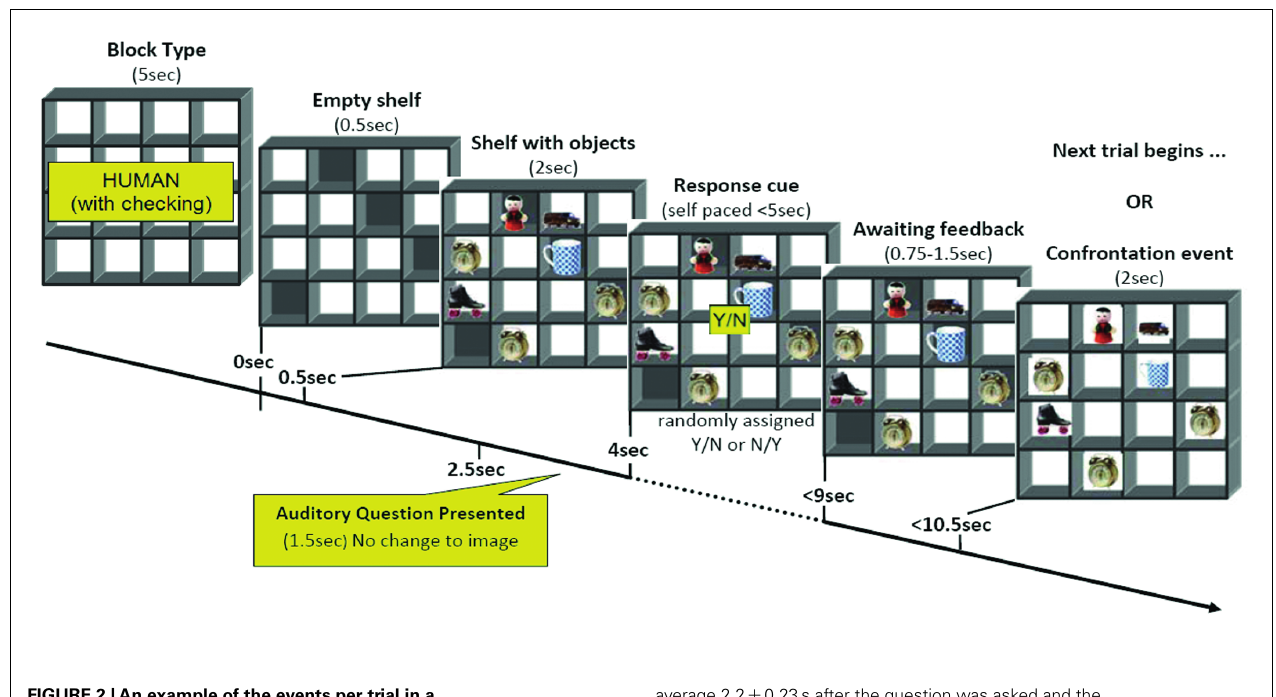
FIGURE 2 |An example of the events per trial in a confrontation block. This figure presents the sequence and duration of events in a trial in blocks where the participants could be confronted with their claims. Participants responded on